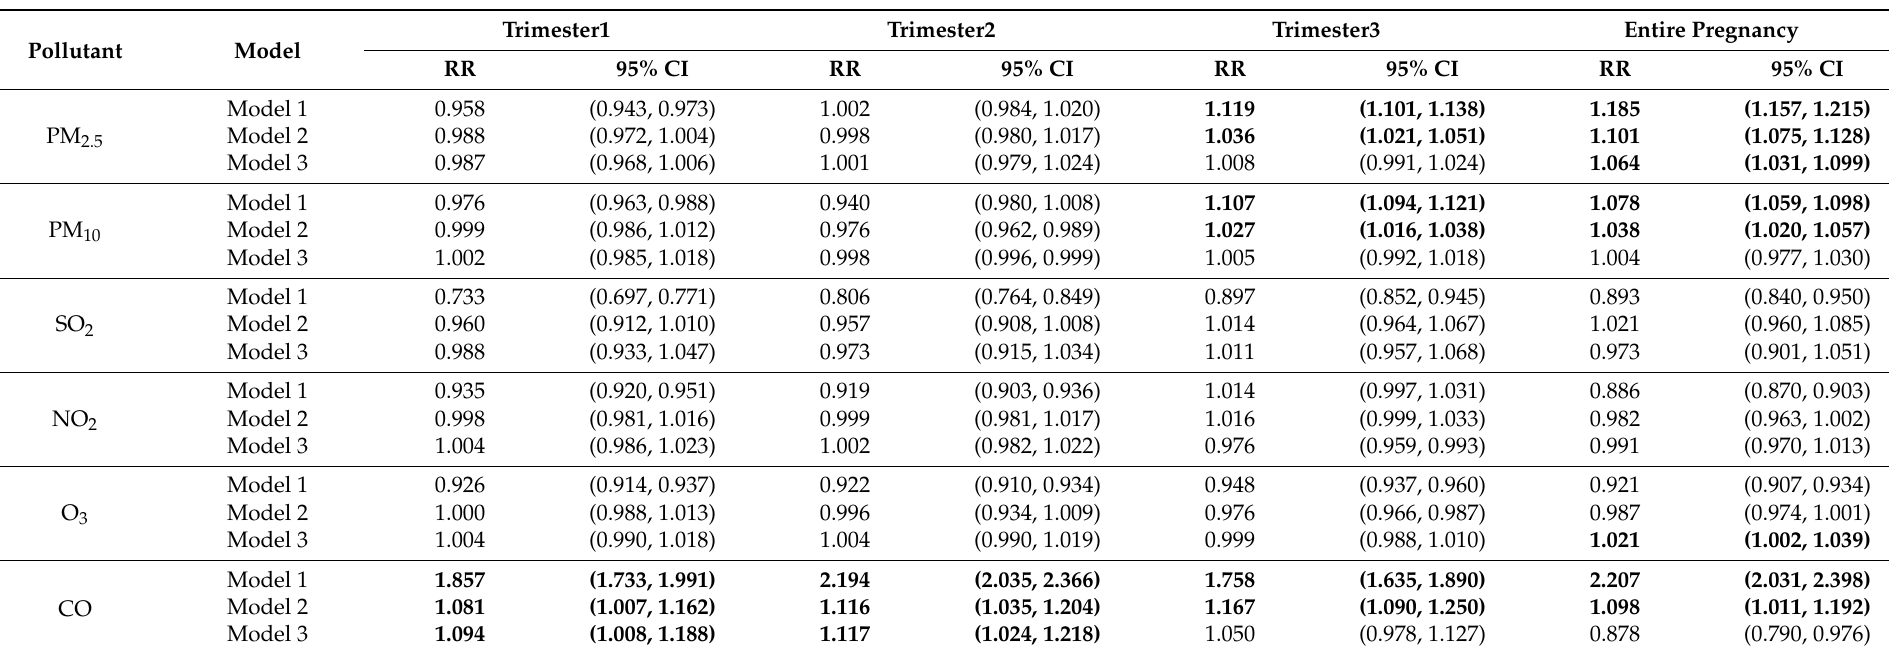
Table 4. Adjusted relative risks (RRs) and corresponding 95% confidence intervals (CIs) from GAM models for PTB to maternal exposure to air pollutants by trimester of